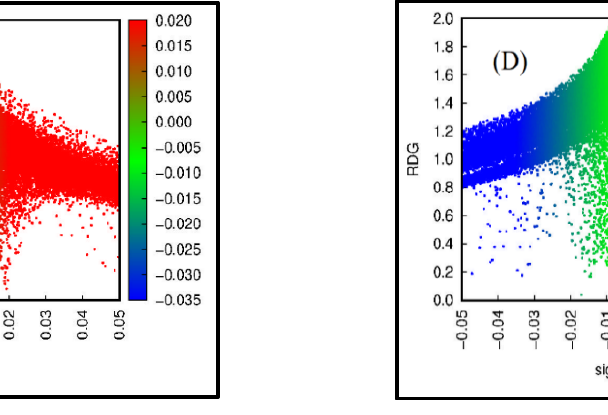
Figure 8. Non-covalent interactions analysed through the RGD method. ( A , B ) The RDG isosurface computed for LGN-CHA and LGN-DDQ, respectively, the LGN cation and the CHA and DDQ anion; ( C , D ) the RDG scatter plot color-graded for LGN-CHA and LGN-DDQ, respectively, in accordance with the interaction type: strong attraction (blue), weak interaction (green), and strong repulsion (red).